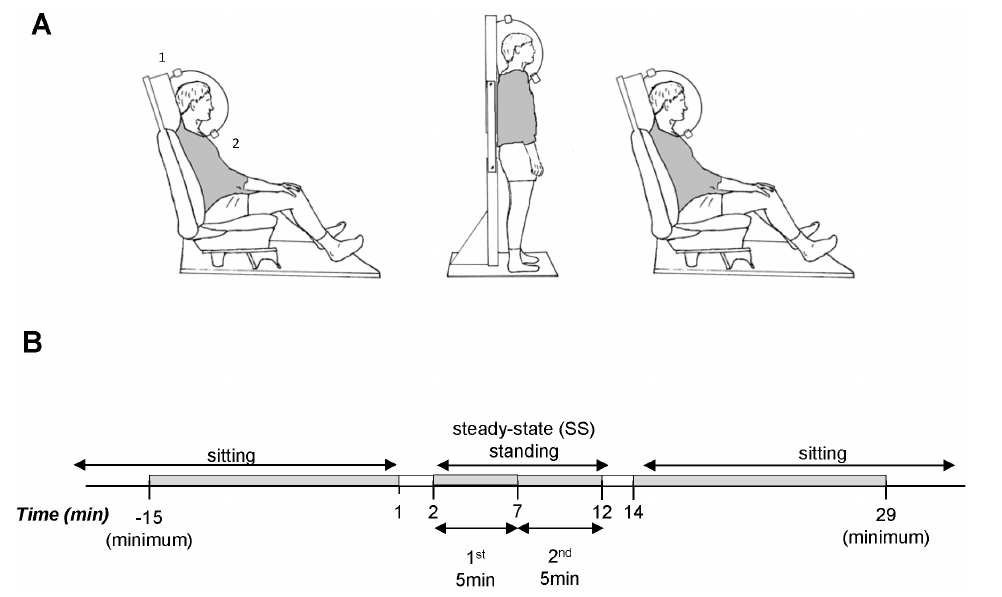
Figure 1. Experimental design and time-line. Schema of experimental design. Posture-adapted ventilated hood indirect calorimetry set-up for sitting and standing measurements (Panel A). The shaded area shows that the area of the subject covered by the veil of the ventilated hood. 1=air inlet; 2=air outlet to Deltatrac. Diagrammatic representation of experimental time-line (Panel B). The shaded areas represent the time periods during which minute-by-minute EE and RQ measurements were recorded. A minimum of 15 min of stable measurements were recorded during each sitting period. During postural transition (from sitting-standing, and standing-sitting) the ventilated hood was removed and no measurements recorded. The 10 min steady-state standing period was further divided into two 5 min blocks for data analysis, referred to as ‘‘1 st 5 min’’ (minutes 3 to 7, inclusive) and ‘‘2 nd 5 min’’ (minutes 8 to 12, inclusive) of the SS-standing period, respectively.